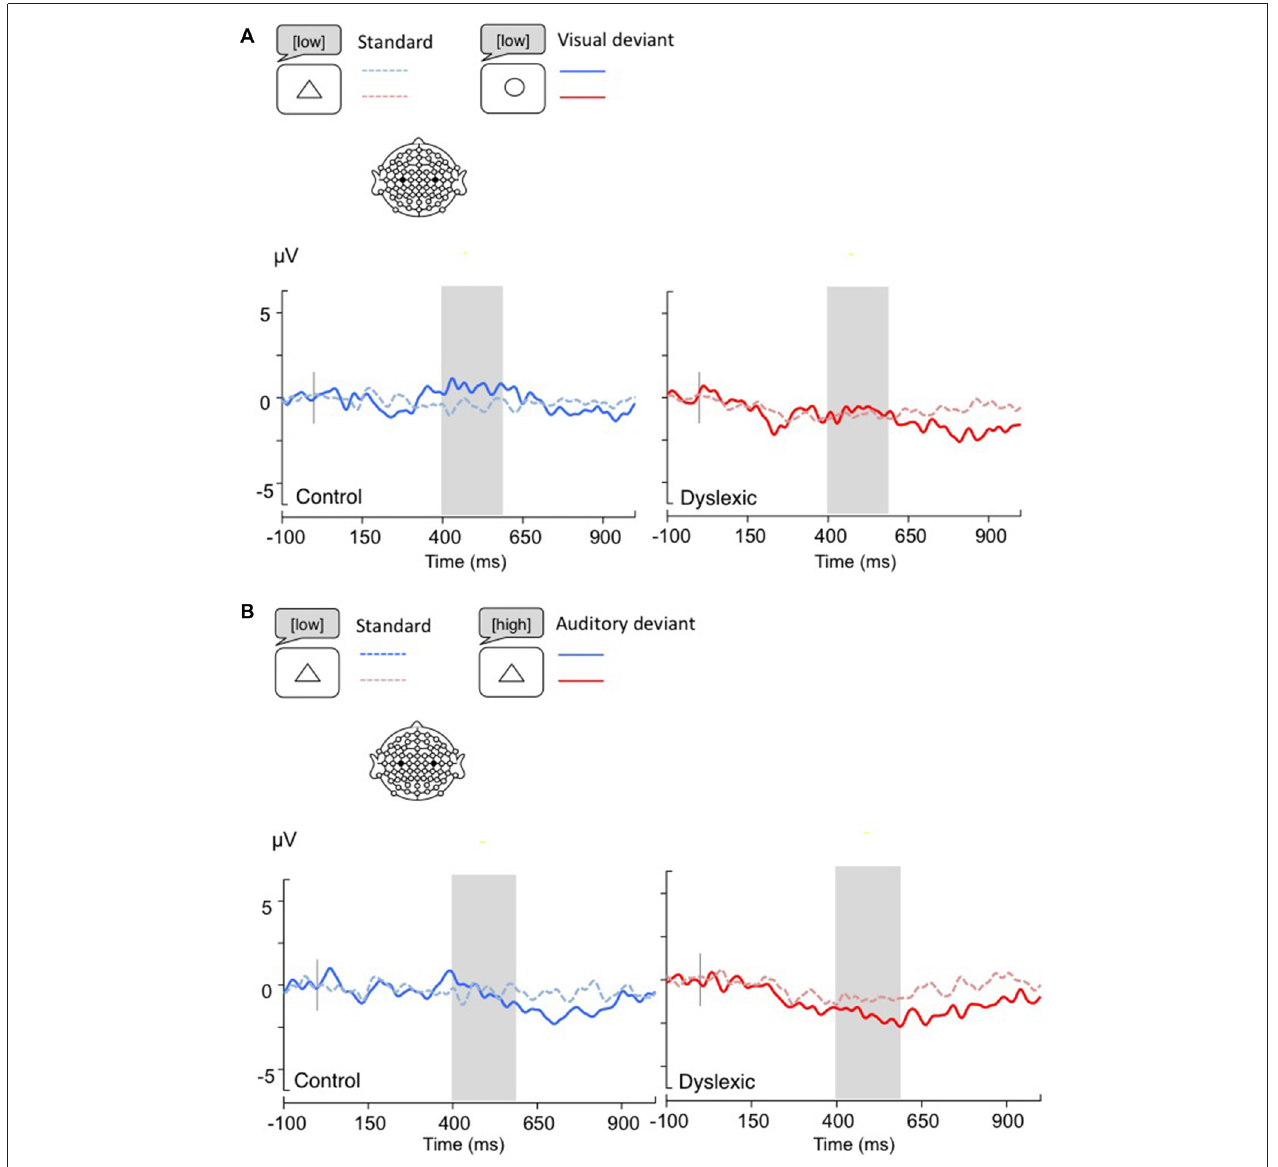
FIGURE 6 | LRPs, calculated by subtracting C4 amplitudes from C3. Gray bar: analysis window. (A) Visual deviants; (B) Auditory